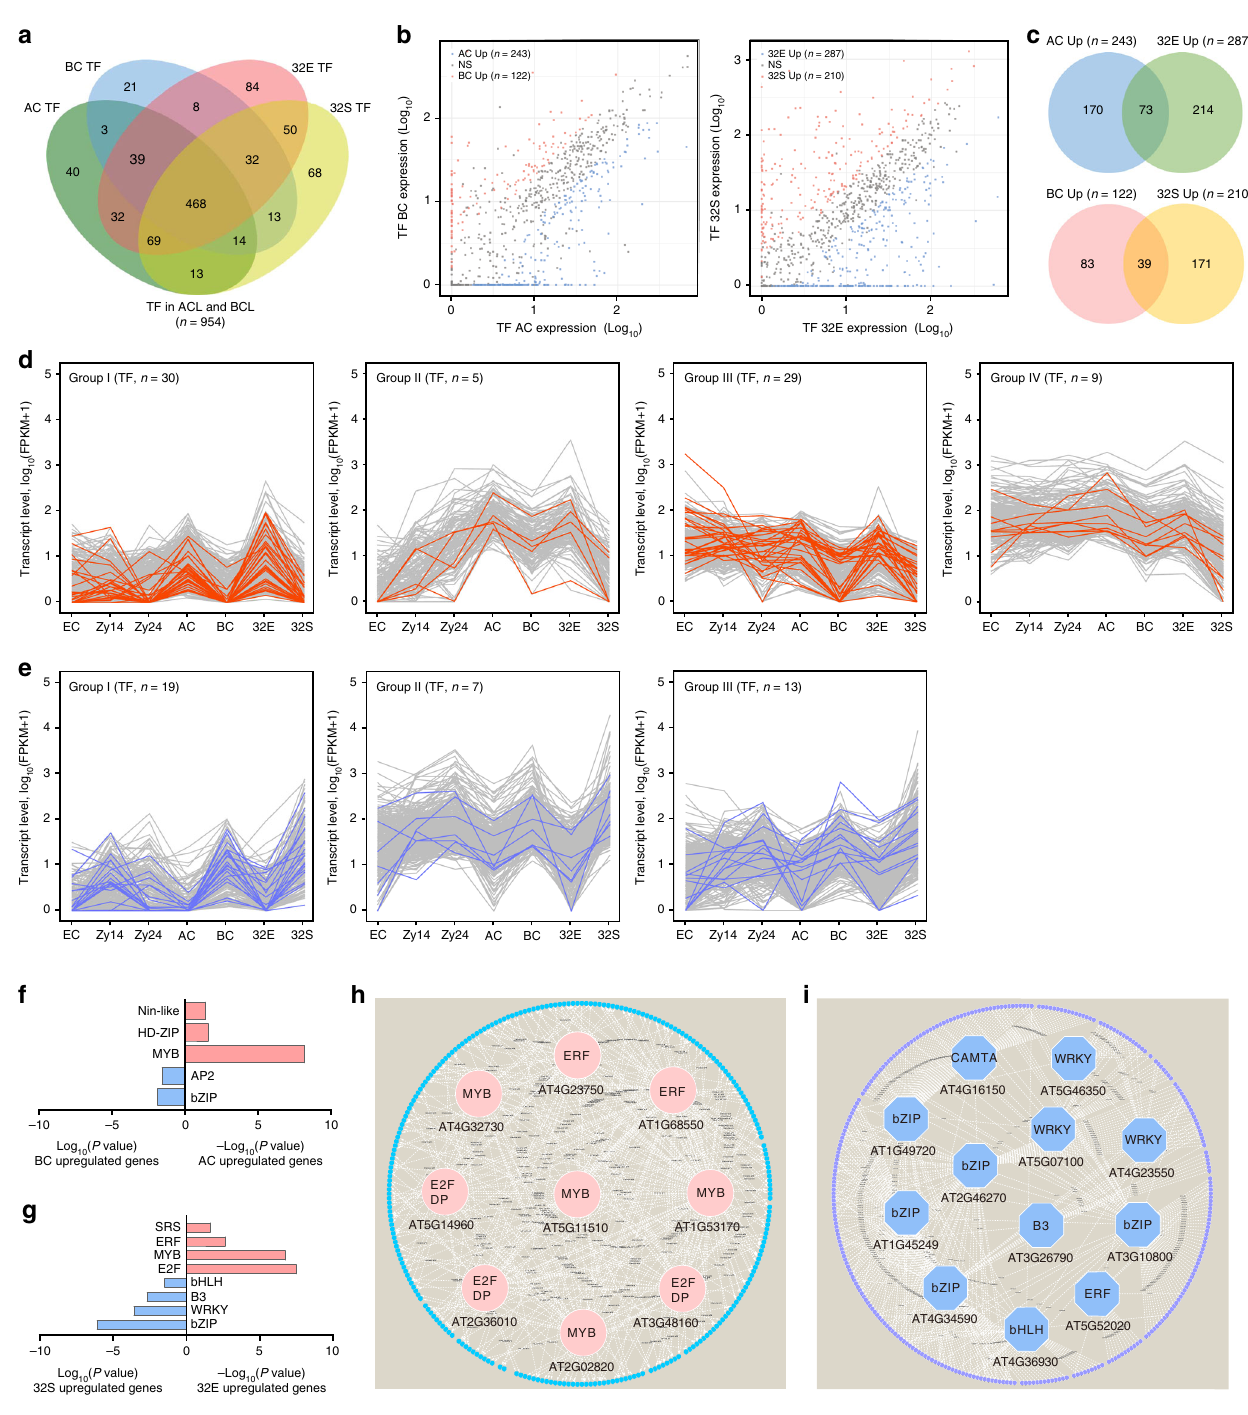
Fig. 7 The regulatory networks of diverse transcription factors in apical and basal cell lineages of early proembryos. a Venn diagram showing expressed TF genes in AC, BC, 32E, and 32S (FPKM ≥ 1). b Scatterplot showing differentially expressed TF genes between AC and BC, and between 32E and 32S. c Overlap analysis of upregulated or downregulated TF genes between AC/BC and 32E/32S. d , e Identi fi cation of TF genes that are coexpressed with apical cell lineage- ( d ) and basal cell lineage-maintained ( e ) genes in early embryogenesis. Orange lines ( d ) and purple lines ( e ) indicate the TF genes in each group. f , g Enrichment of TF DNA binding motifs within the promoter regions of upregulated and downregulated genes between AC/BC ( f ) and 32E/32S ( g ). h , i Predicated regulatory networks between enriched TFs and their potential targeted genes in apical ( h ) and basal cell ( i )